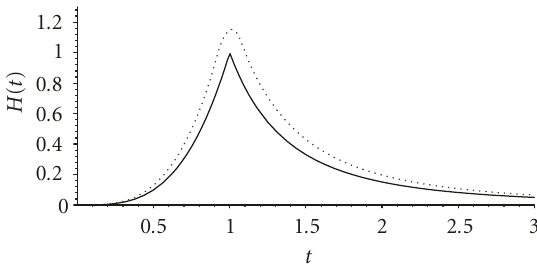
Figure 2.1. Approximative graphic of the functions u ( t , x ) (dotted line) and H ( t ) (solid